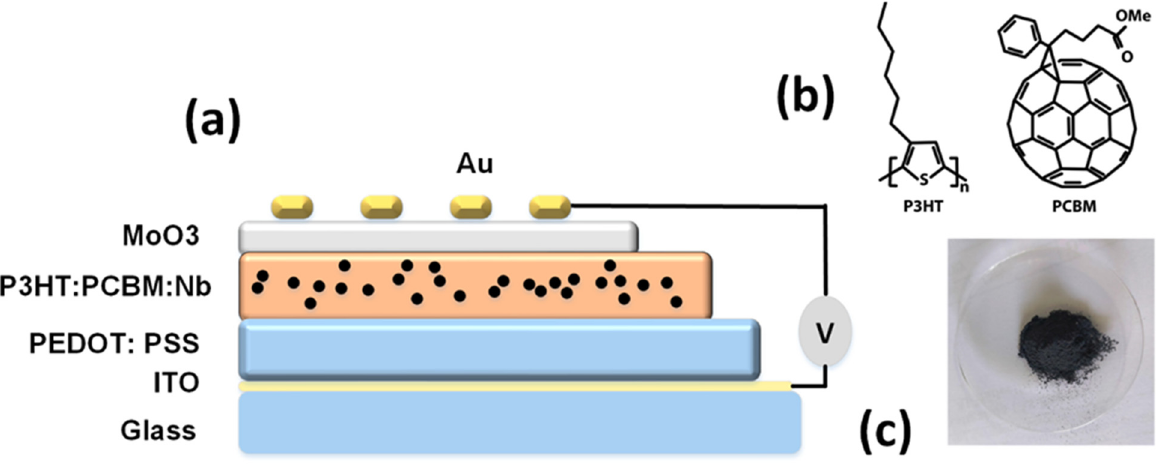
Figure 1. ( a ) Solar cell with a glass/ITO/PEDOT:PSS/P3HT:PCBM:Nb/MoO 3 /Au structure with Nb nanoparticles embedded in active layers, ( b ) molecular structures of P3HT and PCBM, and ( c ) niobium (Nb)